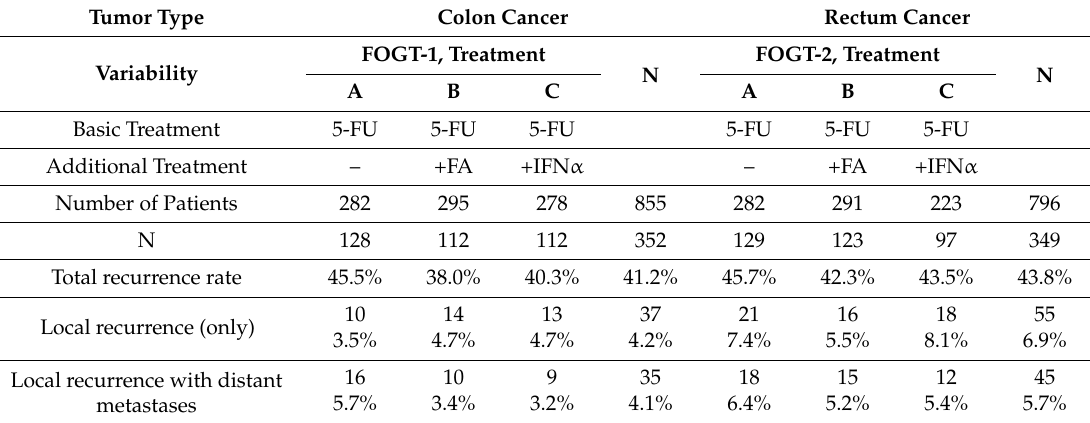
Table 7. Frequency and location of recurrence after adjuvant chemo- or radiochemotherapy of